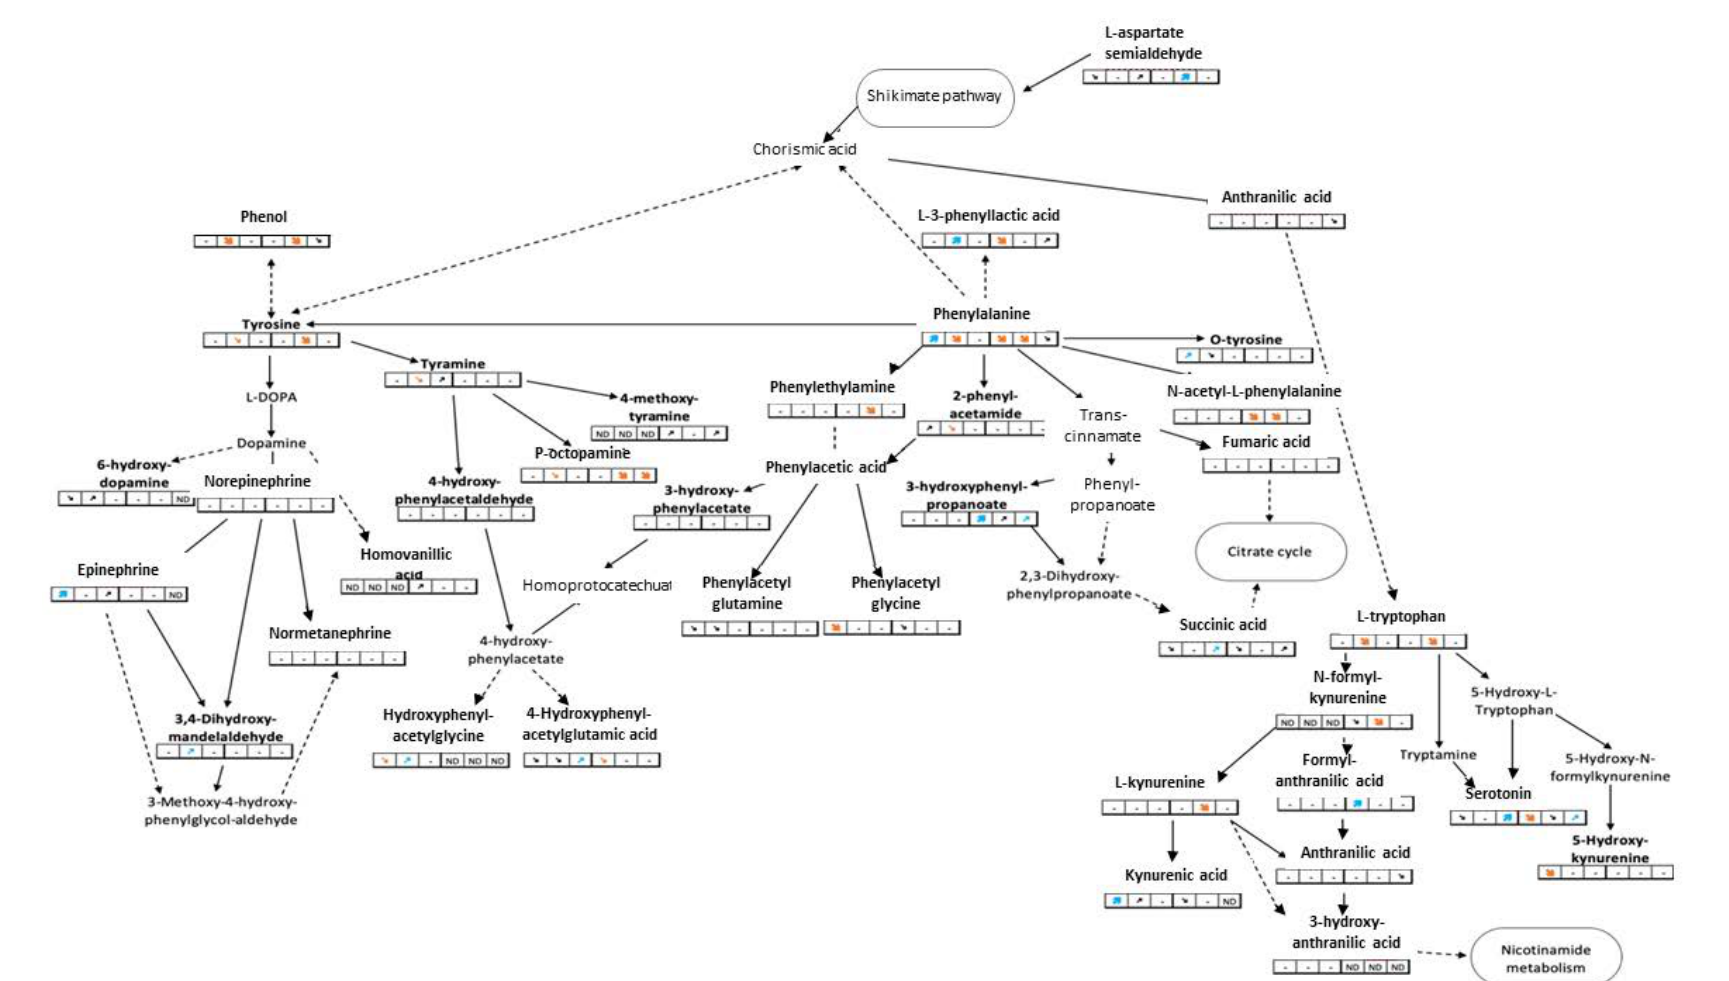
Figure 1. Partial metabolic pathways of tyrosine, phenylalanine, and tryptophan. Bold metabolites are those detected in our study, plain arrows between two metabolites represent direct links, dashed arrows represent incomplete links. Tables below metabolites are extracts of the Table 2: the first 3 boxes represent modulations in male mussels and the last 3 boxes concern female mussels. Colored arrows represent a trend or a significant modulation (when